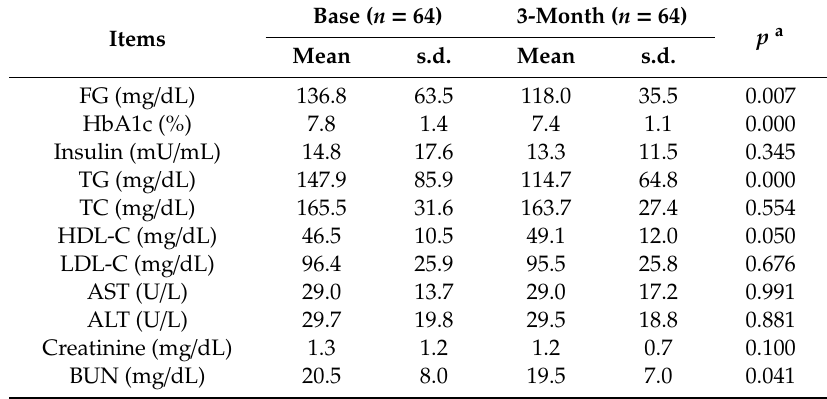
Table 3. Independent t -test of laboratory values, test group.